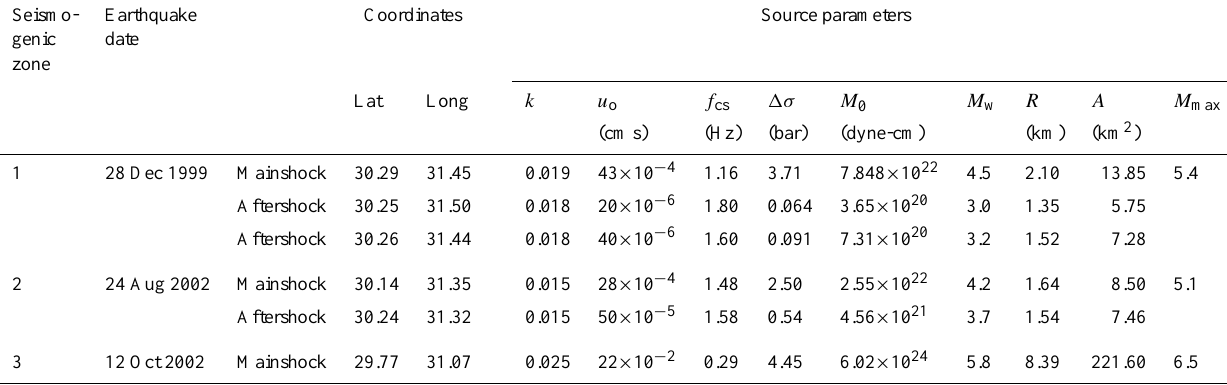
Table 3. Source parameters of the effective earthquakes from different seismogenic zones.